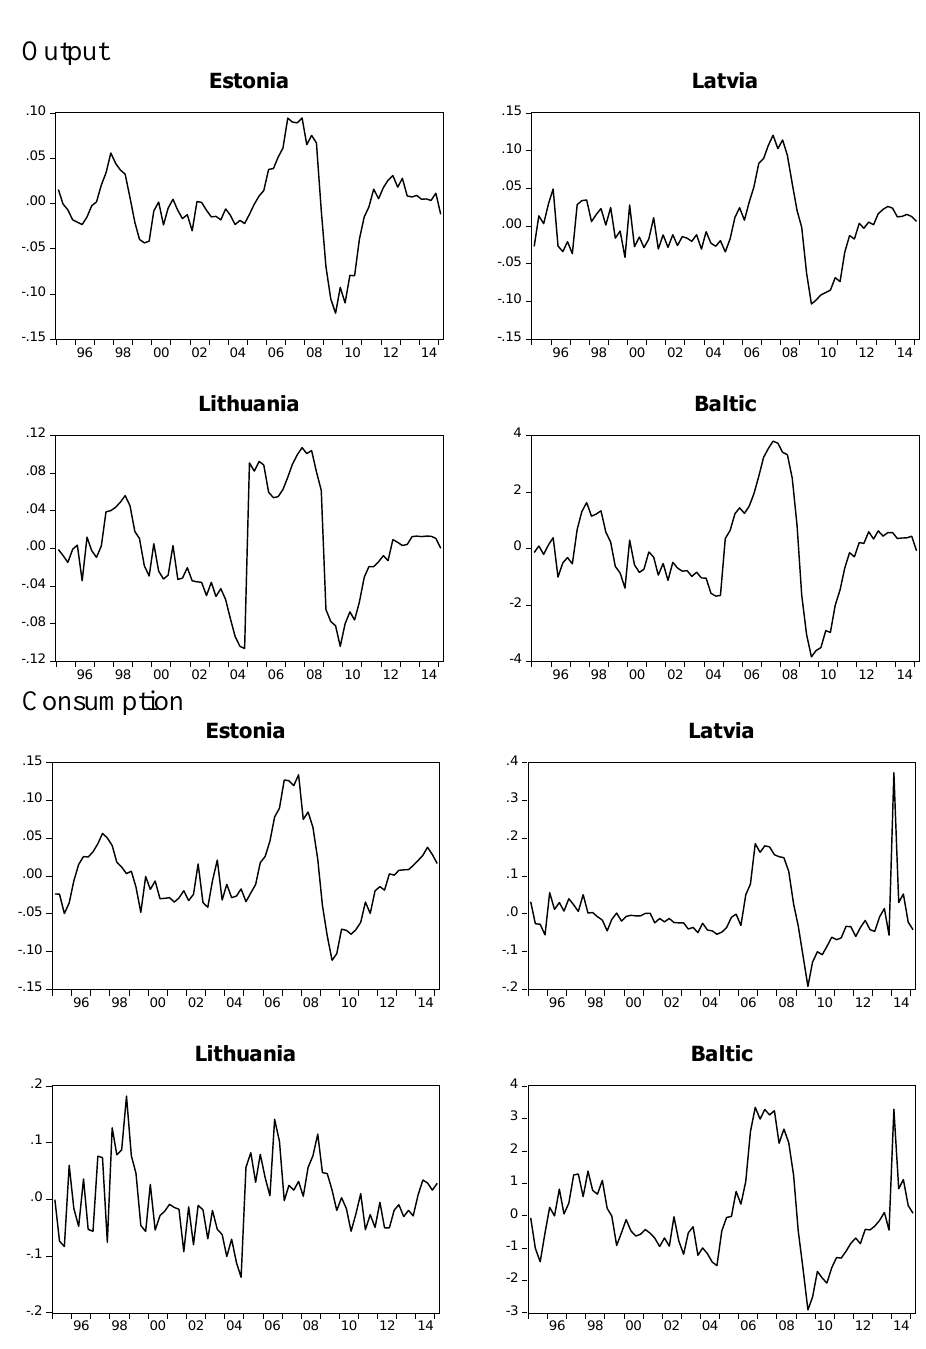
Fig. 1. Baltic output and consumption cycles, quarterly, 1995–2015 (International Monetary Fund, calculations by the